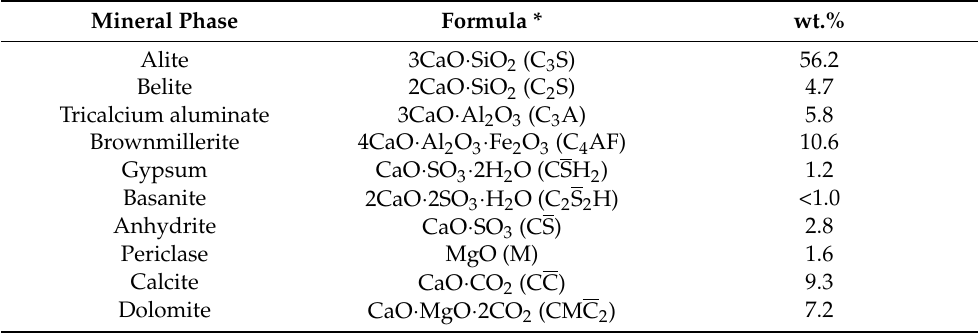
Table 1. Quantitative phase analysis of Portland-limestone cement derived from Rietveld refinements of X-ray powder diffraction data (Bragg R factor −